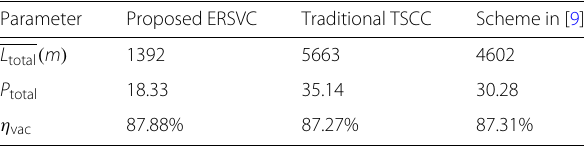
Table 4 Comparison of performance for proposed ERSVC and TSCC in the 50-node network Parameter Proposed ERSVC Traditional